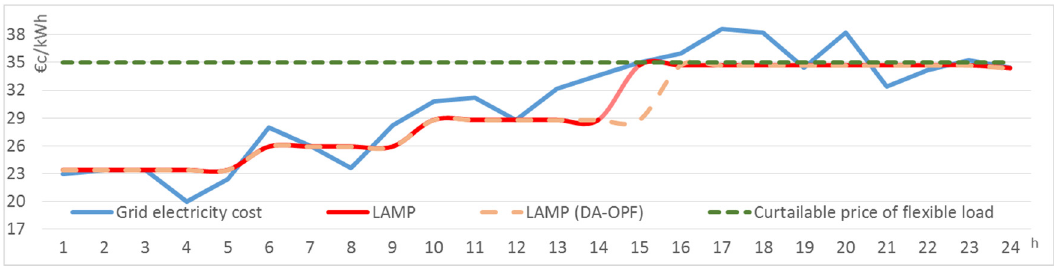
Figure 9. Grid electricity price, locational average marginal price (LAMP), and curtailable price of flexible load (winter case).